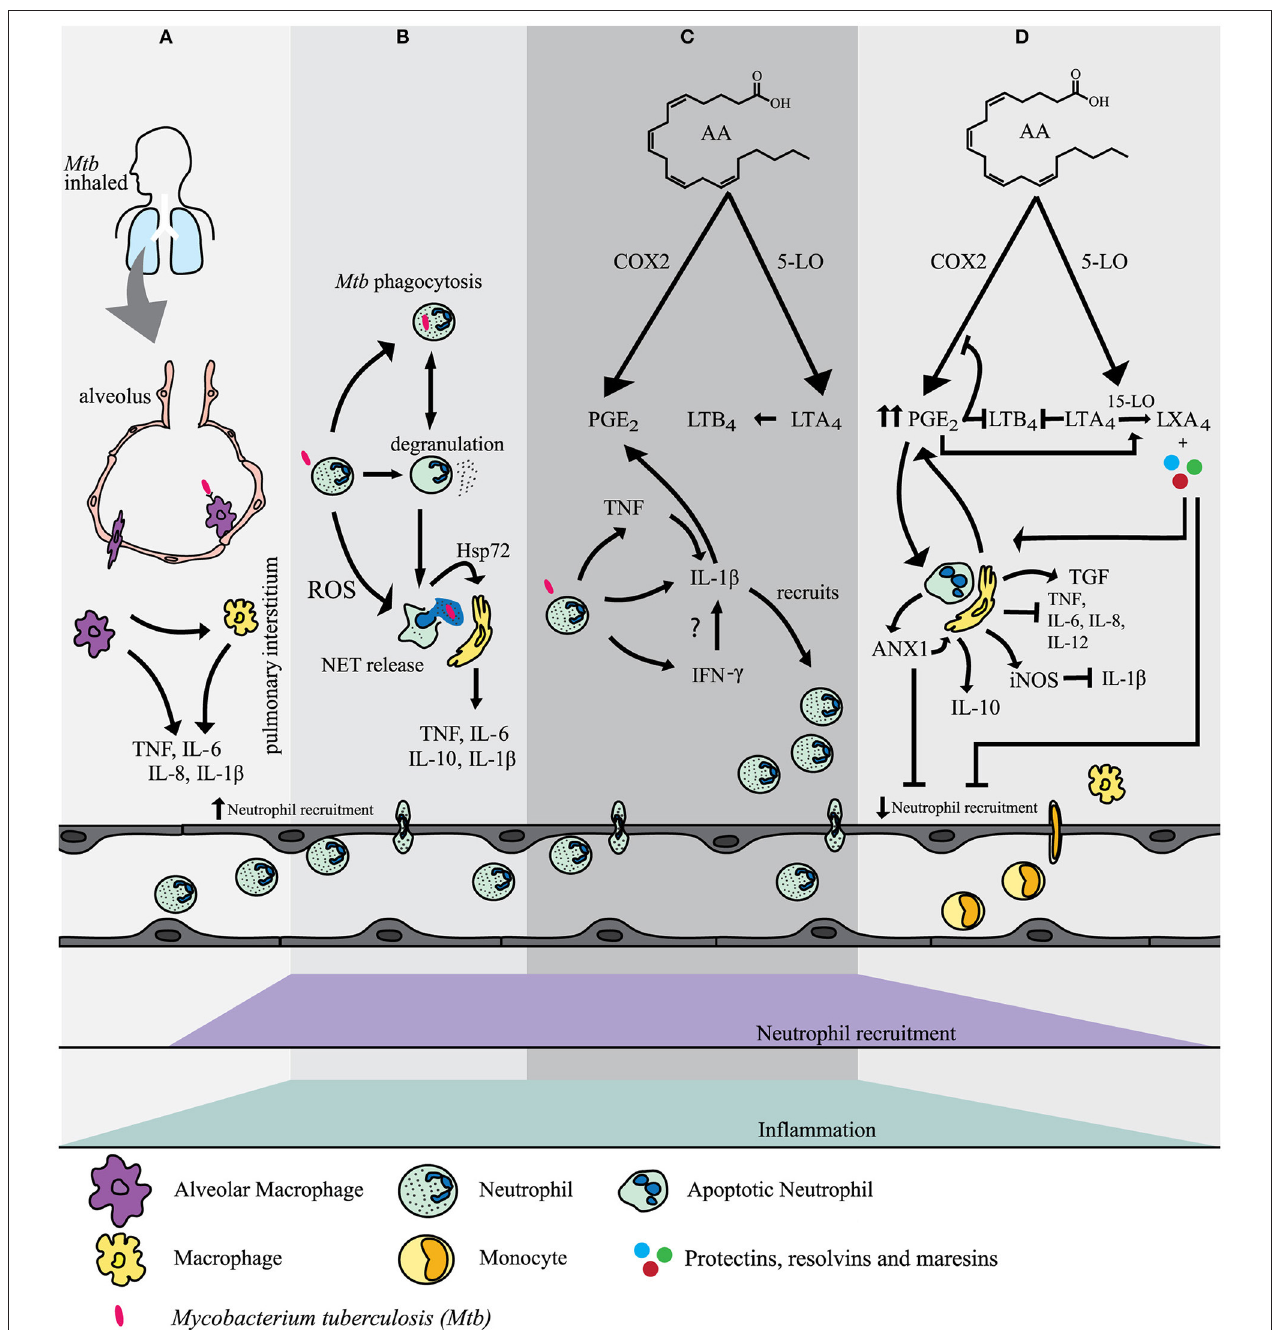
FIGURE 1 | (A) Alveolar macrophages (AM) are the first cells to encounter M. tuberculosis after inhalation of the bacillus. Acute pro-inflammatory signals are released by AM and local tissue macrophages to recruit neutrophils to the site of infection. (B) Neutrophils use a variety of mechanisms to mediate M. tuberculosis infection. These included phagocytosis, degranulation, ROS formation and NET release. NETs transfer Hsp72 to adjacent macrophages inducing a pro-inflammatory response. (C) Interaction of recruited neutrophils with M. tuberculosis mediates the activation of several pathways which contribute to inflammation and clearance of M. tuberculosis infection. Interleukin-1 β (IL-1 β ) release is mostly mediated in an inflammasome dependent manner. Tumour necrosis factor (TNF) induces NF- κ B which mediates the induction of gene expression of IL-1 β in neutrophils. Interferon- γ (IFN- γ ) may also regulate the release of IL-1 β . IL-1 β is a key player in mediating the release of prostaglandin E 2 (PGE 2 ) and leukotriene B 4 (LTB 4 ) both of which contribute to inflammation and the recruitment of neutrophils. (D) PGE 2 eventually becomes a stop signal and has a negative feedback on cyclo-oxygenase-2 (COX-2) and 5-lipoxygenase (5-LO). The production of lipoxin A4 (LXA4) is favoured. In addition, AnnexinA1 (ANX1) stimulates IL-10 release by macrophages. Neutrophils express inducible nitric oxide synthase (iNOS) which has a further negative feedback on IL-1 β release. The net effect is an increase in neutrophil apoptosis and clearance by tissue macrophages. More macrophages are recruited and further neutrophil recruitment is inhibited and inflammation is